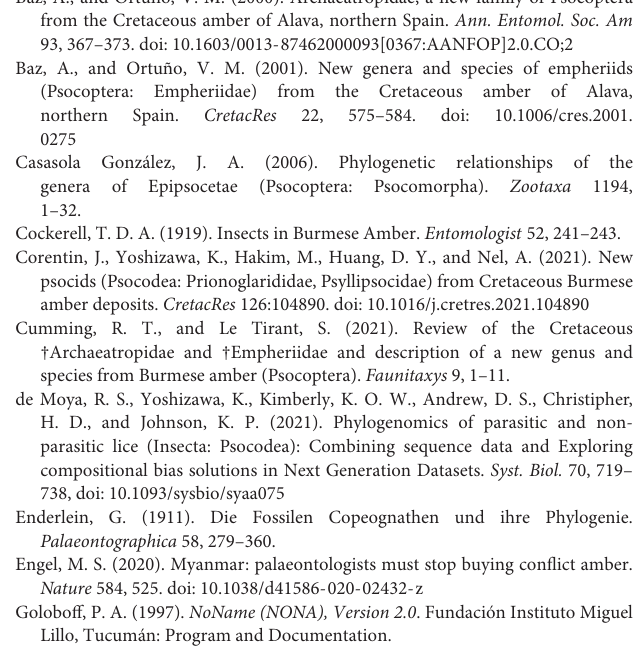
Supplementary Figure 1 | The most parsimonious tree obtained by TNT analysis. Phylogeny of Atropetae based on 18 species and 38 characters, with characters being nonadditive, under equal weighting. Analyzed with TNT v1.5. * Representsthe genus originally placed in